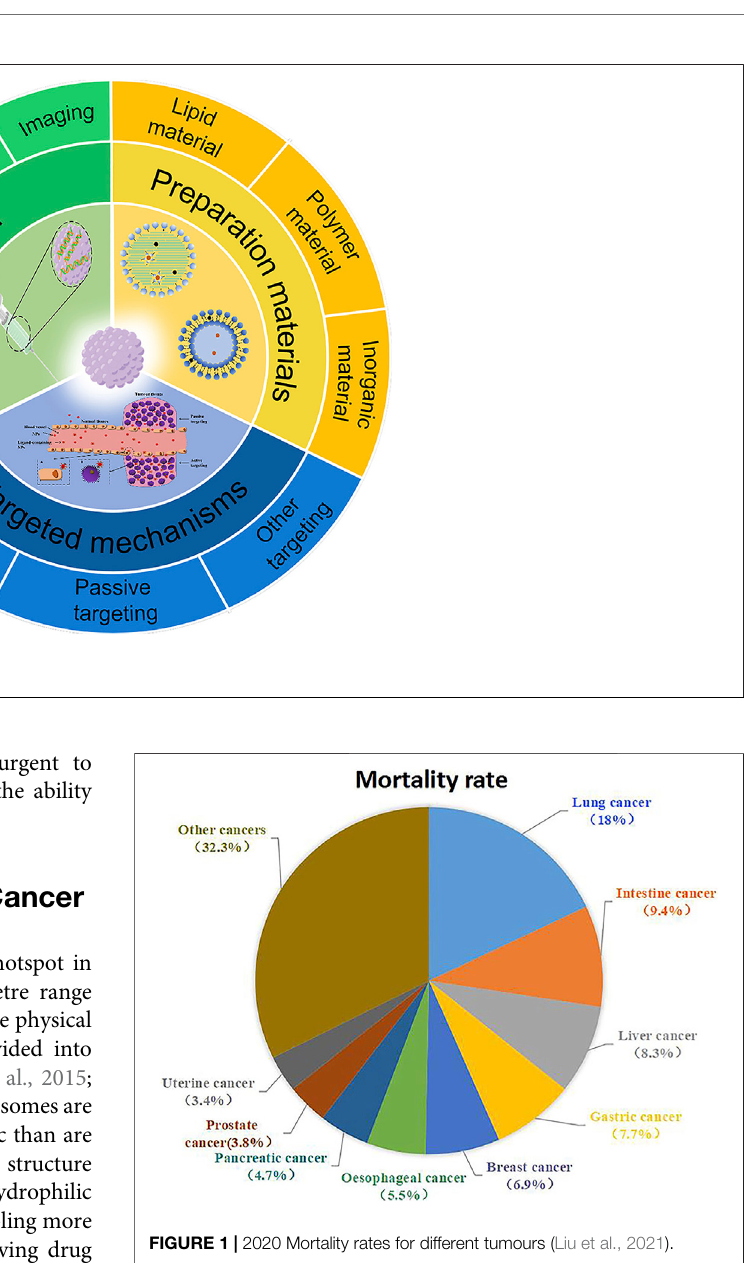
FIGURE 1 | 2020 Mortality rates for different tumours (Liu et al.,